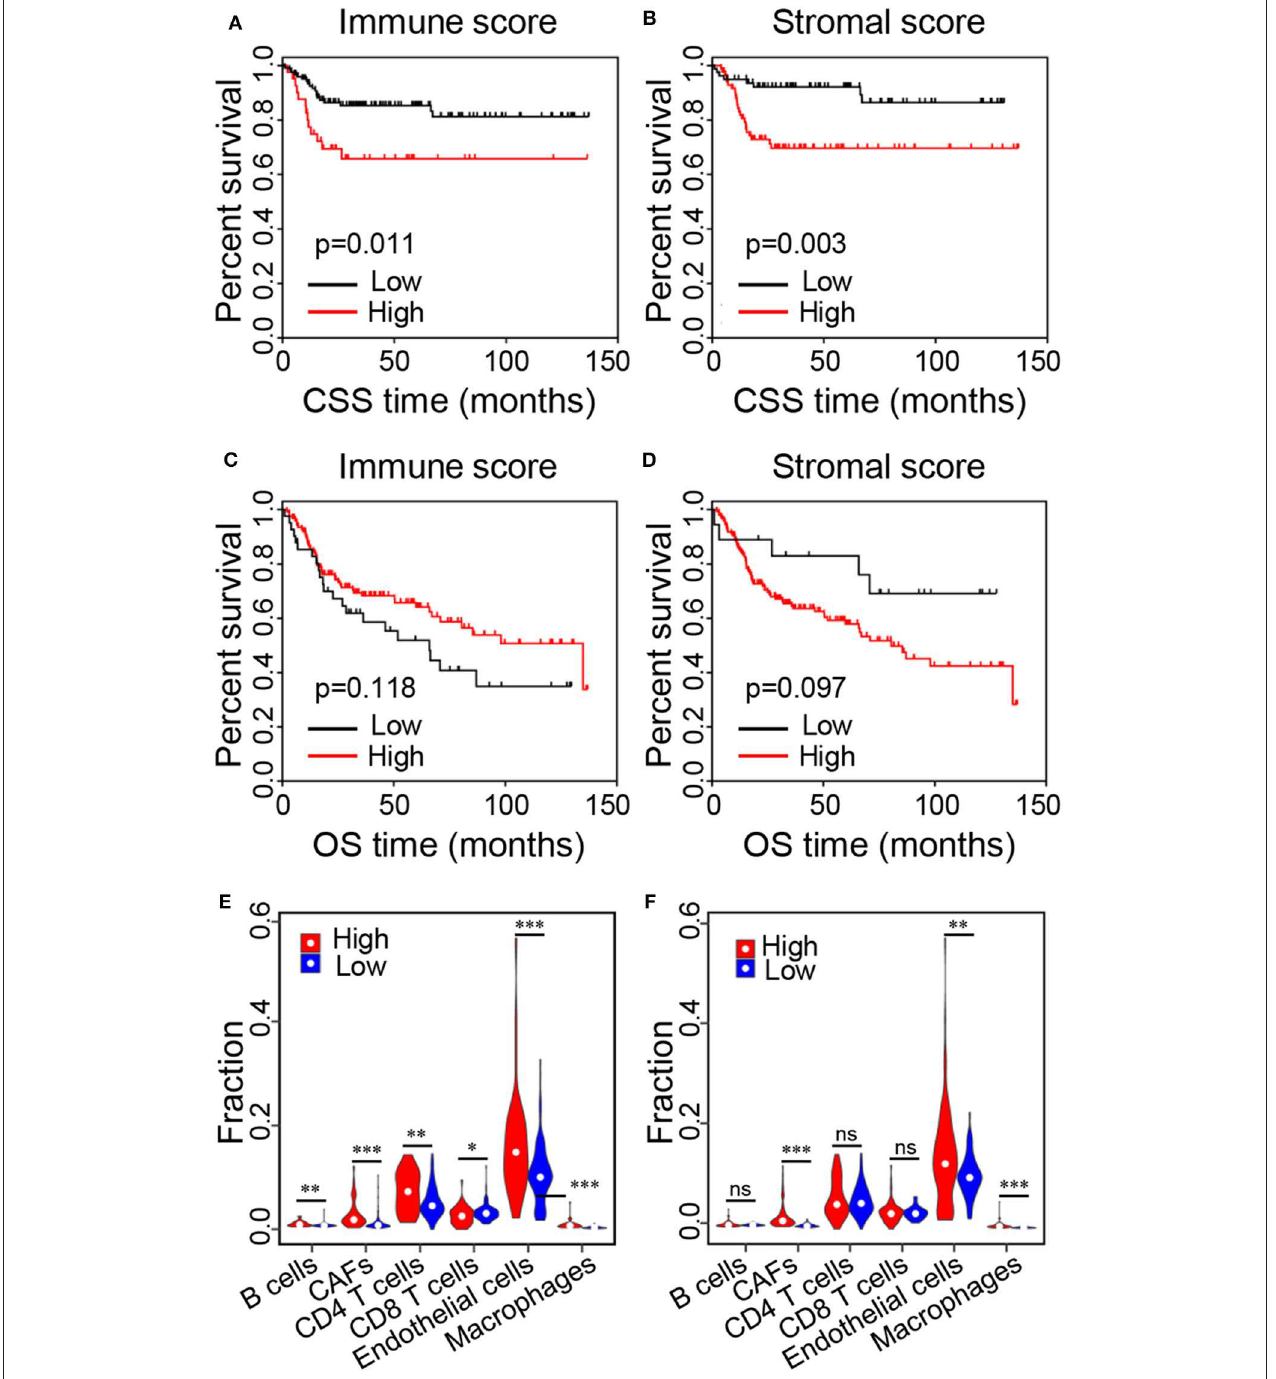
FIGURE 2 | Kaplan–Meier survival curves of BC patients and relative proportions of immune cells in the high and low score groups. (A,B) Kaplan–Meier curves of CSS for patients with low vs. high immune and stromal scores. (C,D) Kaplan–Meier curves of OS for patients with low vs. high immune and stromal scores. (D–F) Relative proportions of immune cells in the low vs. high immune and stromal score groups (* p < 0.05, ** p < 0.01, *** p < 0.001, ns, no significance). CSS, cancer-specific survival; OS, overall survival. were identified ( Figure 4B ). Finally, the risk prediction model ( Supplementary Table 2 ). Then, the 45 significant genes from was built with the three immune-related genes, namely, COL1A1, the result of the univariate regression were utilized for the COMP, and multiple LASSO regression ( Figure 4A ), and three key genes